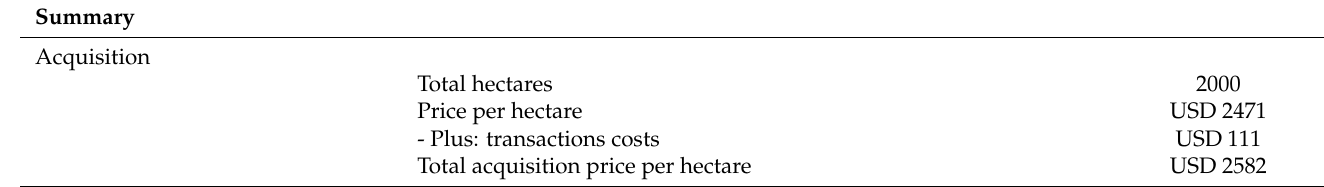
Table 1. Costs, revenues, and internal rate of return (IRR) for a parcel in average condition for the modeled region of northwestern Maine under EF management, assuming a 15-year holding period.